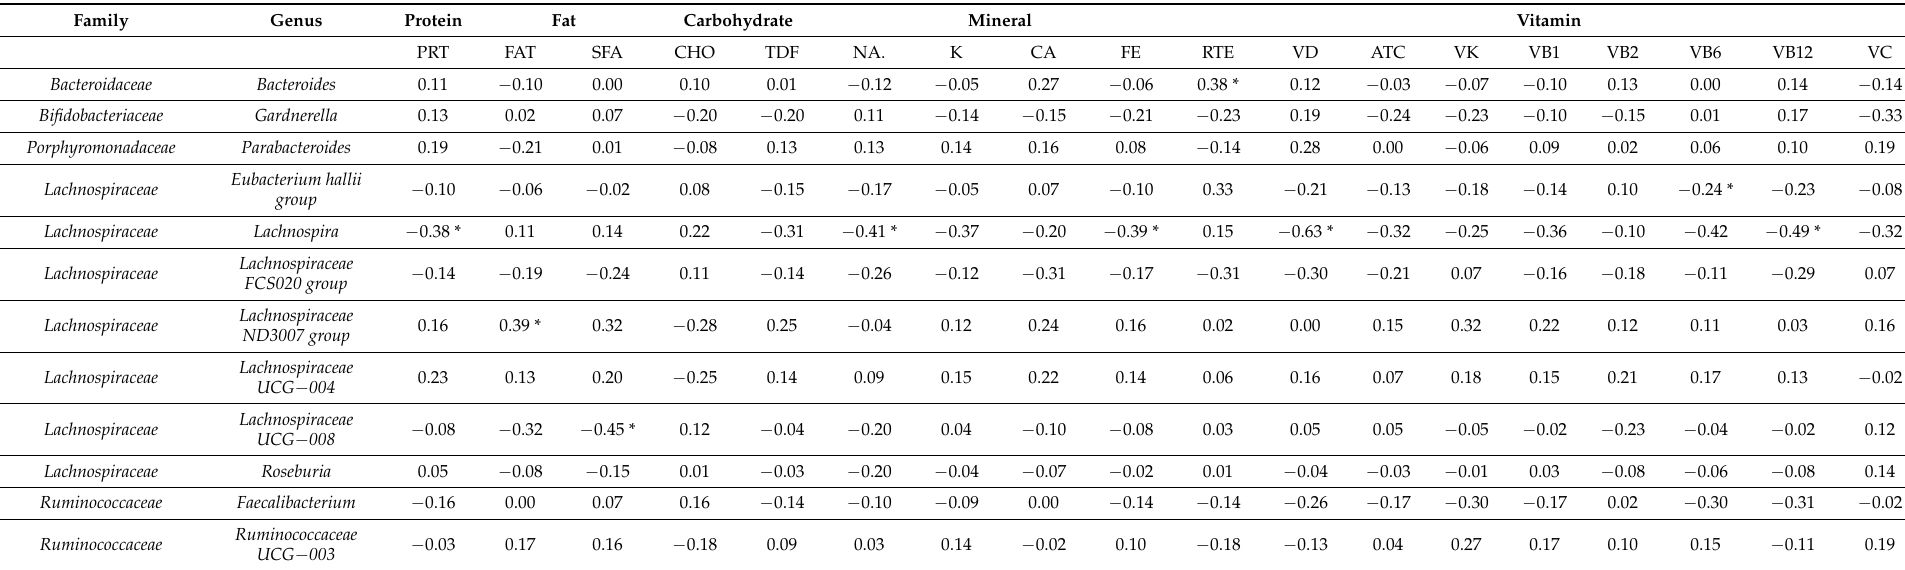
Table 3. Correlations between the targeted genera and nutrient